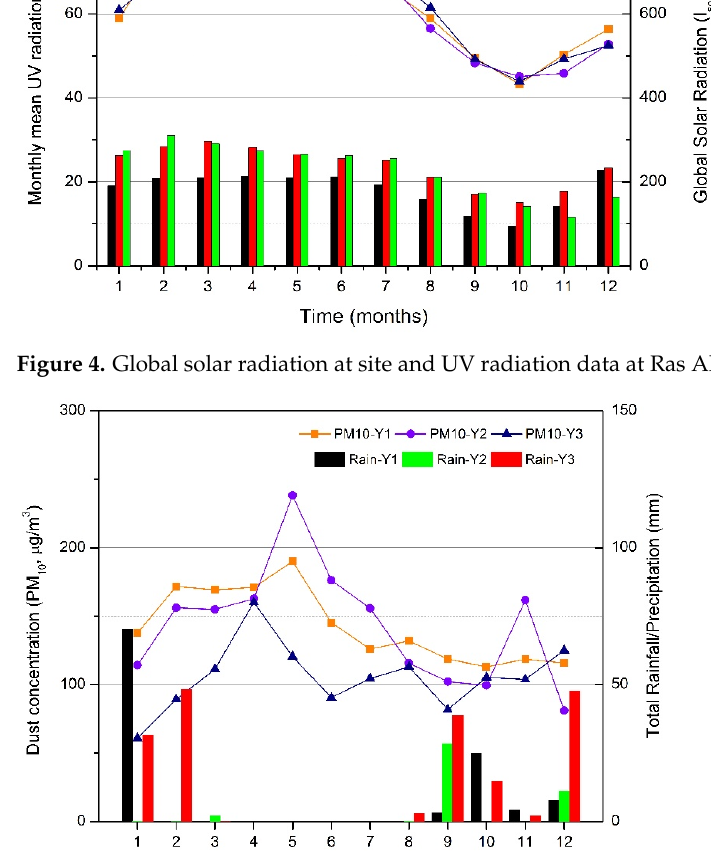
Figure 4. Global solar radiation at site and UV radiation data at Ras Al Khaimah, UAE.